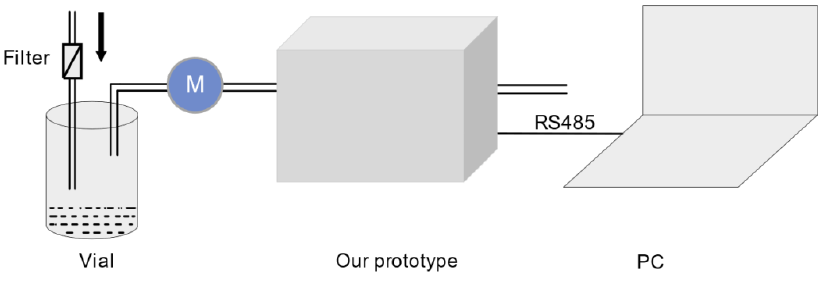
Figure 3. Illustration of the sample detection. Table 2. Details of wine samples with different producing area.